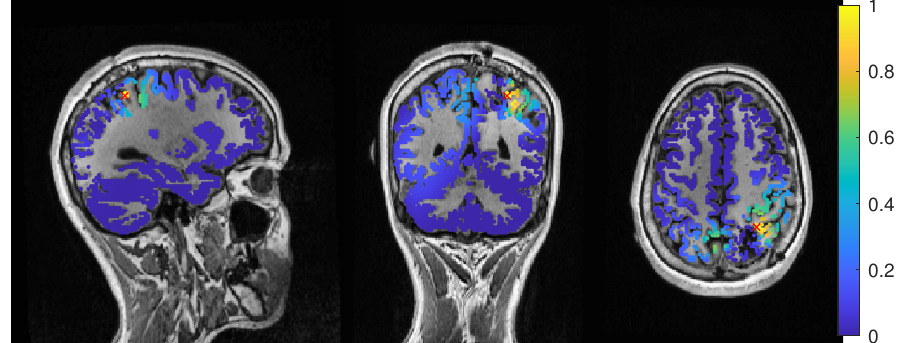
Figure 4. Patient 1’s result of the EEG average-based beamformer in the 6 compartment head model at 0.04 regularization with sagittal ( left subfigure), coronal ( middle subfigure) and axial ( right subfigure) cuts through T1 MRI and source space. Note that the MRI is not in radiological convention.